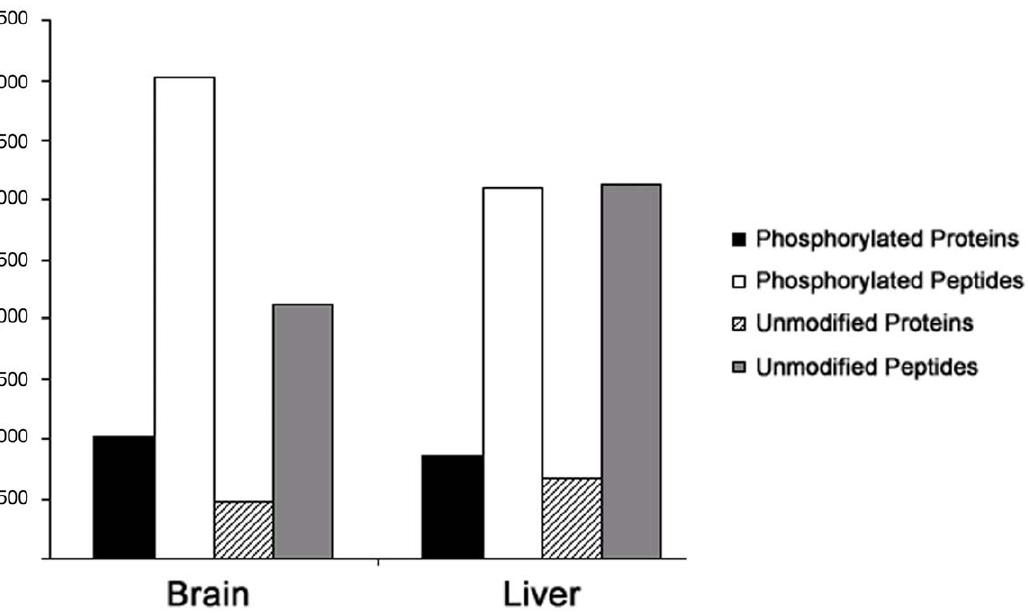
Figure 1. Peptide identifications from liver and brain tissue. The number (y-axis) of phosphorylated and unmodified proteins identified from brain and liver on a LTQ-Orbitrap mass spectrometer following the phosphopeptide enrichment using IMAC.